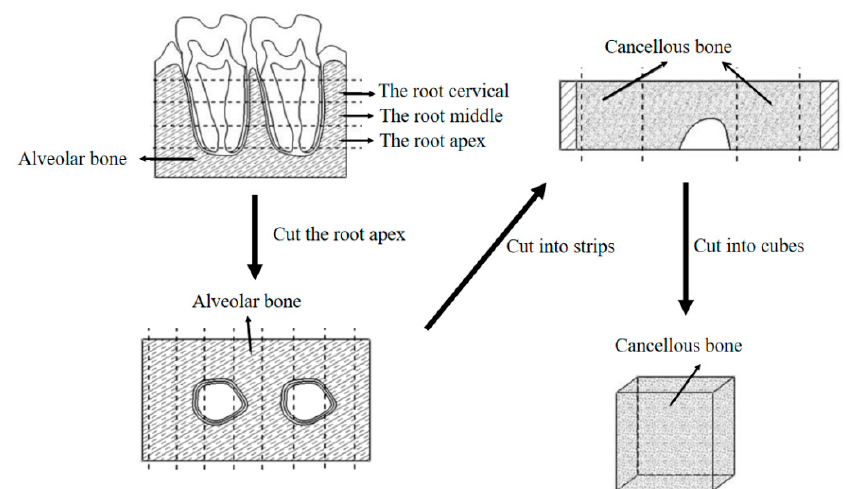
Figure 1. Flow chart of CBAB preparation. Table 1. CBAB sample parameters.